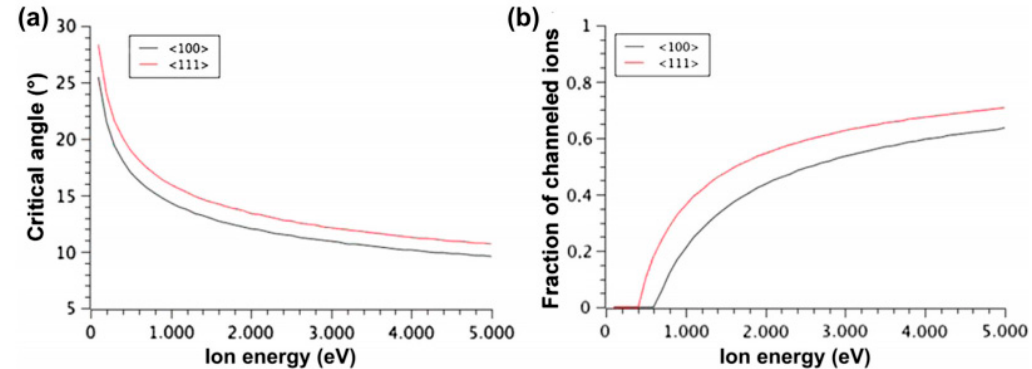
Figure 7. ( a ) Critical angle for low-energy nitrogen ions in (100) and (111) diamond; ( b ) Fraction of channeled ions in (100) and (111) diamond. Adapted from